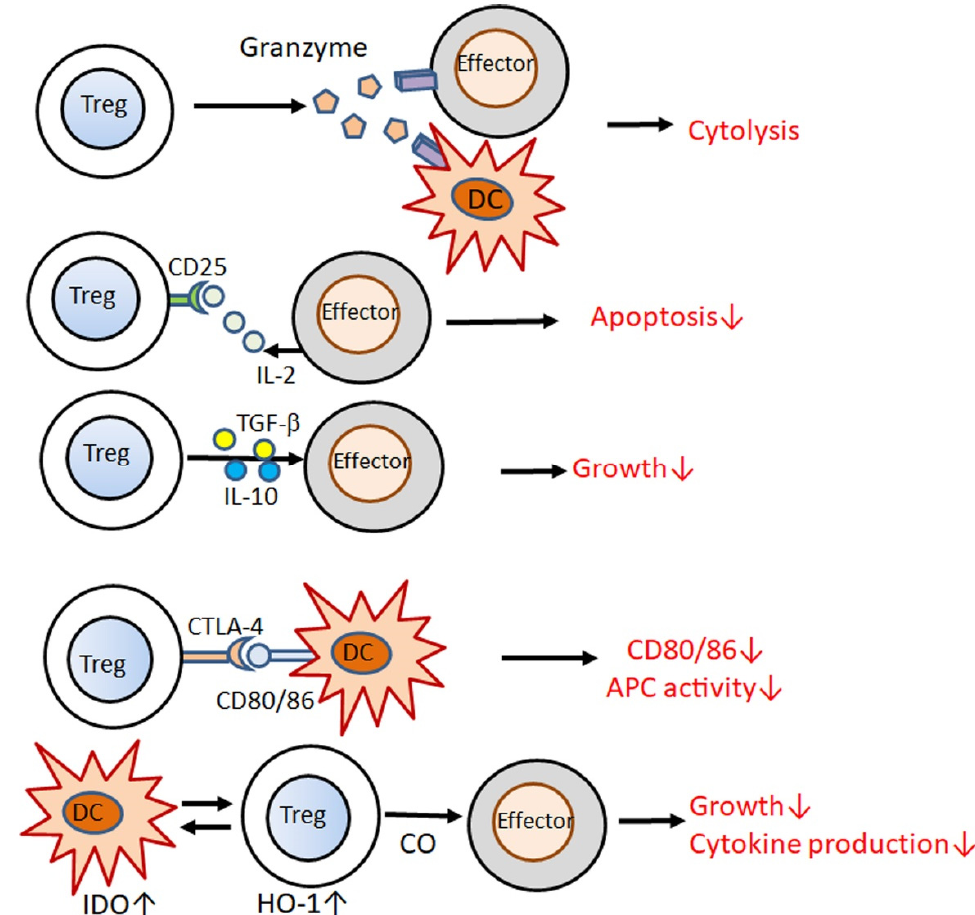
Figure 2. Possible mechanisms for immunosuppression by CD4 + CD25 + Forkhead box protein 3 (Foxp3) + regulatory T cells (Tregs). Tregs kill effector T cells and dendritic cells (DCs) by granzymes; Tregs deprive interleukin (IL)-2 from effector T cells; Tregs secrete IL-10 and transforming growth factor- β (TGF- β ), which suppress the proliferation of effector T cells; cytotoxic T-lymphocyte antigen 4 (CTLA4) binding to CD80/86 downregulates CD80/86 and capacity of antigen-presenting cells (APCs) in DCs; interaction with Tregs induces the activity of indoleamine 2,3-dioxygenase (IDO) in DCs, which further activates heme-oxygenase-1 (HO-1) in Tregs, releasing carbon monoxide (CO), which inhibits the activity of effector T cells.